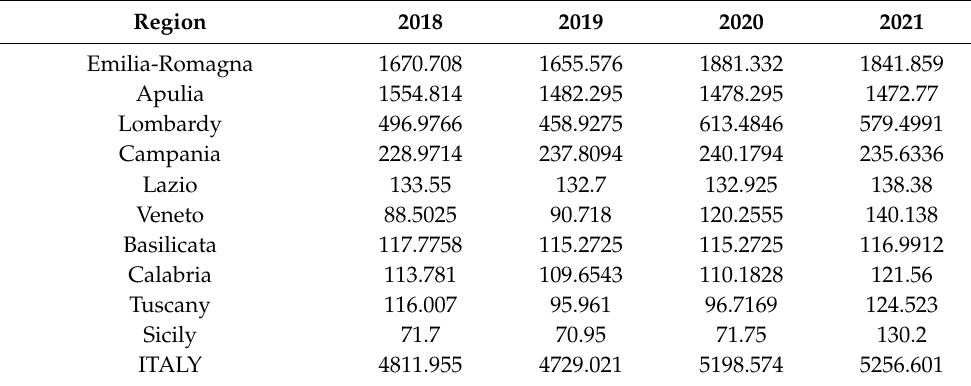
Table 1. Main Italian tomato producing regions (value in 000